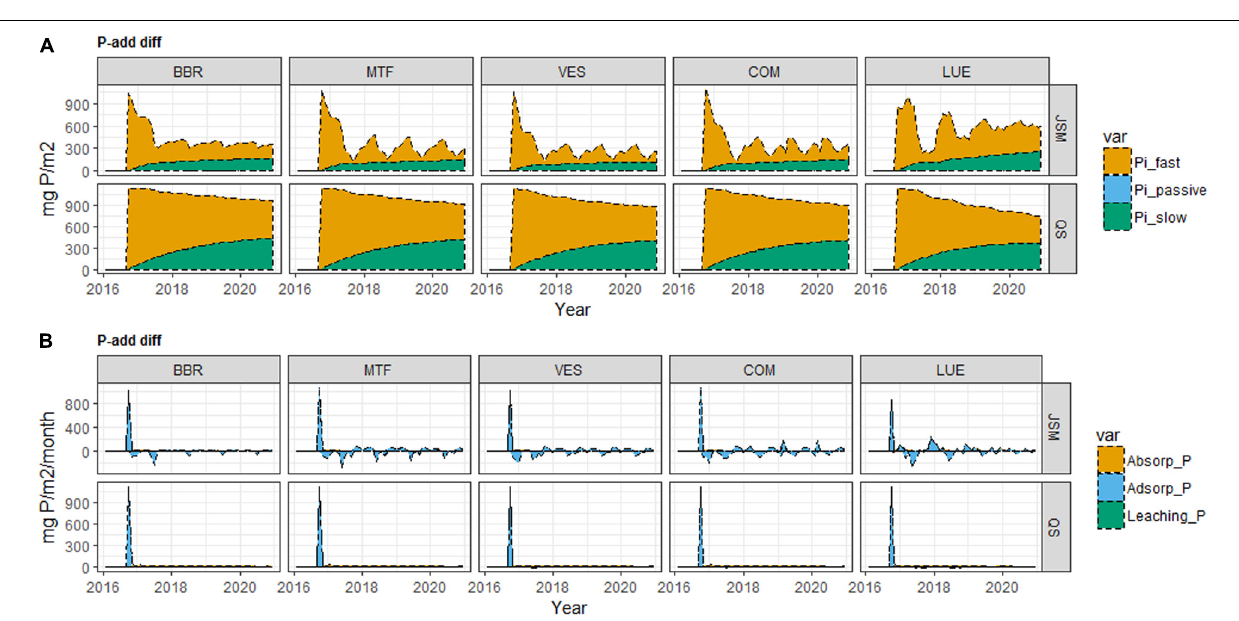
FIGURE 5 | Simulated (A) soil inorganic P (SIP) pool responses and (B) inorganic P cycling processes responses to P addition (P-add diff) of JSM and QUINCY-soil (QS) at the study sites along the soil P gradient (BBR > MTF > VES > COM > LUE). In both models, fast Pi refers to soluble and labile inorganic P pools, slow Pi refers to strongly sorbed P pool, and passive Pi refers to occluded and primary P pools; adsorption (adsorp_P) and absorption (absorp_P) refer to transfer of P from soluble pool to labile pool and from labile pool to sorbed pool, respectively. Time for P addition: September